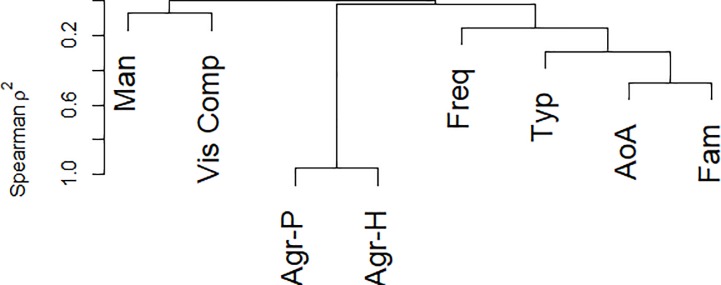
Hierarchical clustering analysis using Spearman’s p2 for the eight explored variables.See the Note in Table 1.